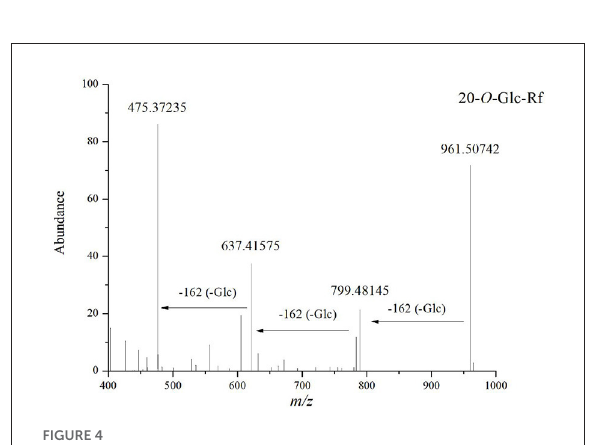
FIGURE4 Tandem mass spectrum of ginsenosides in the negative ion mode: 20- O